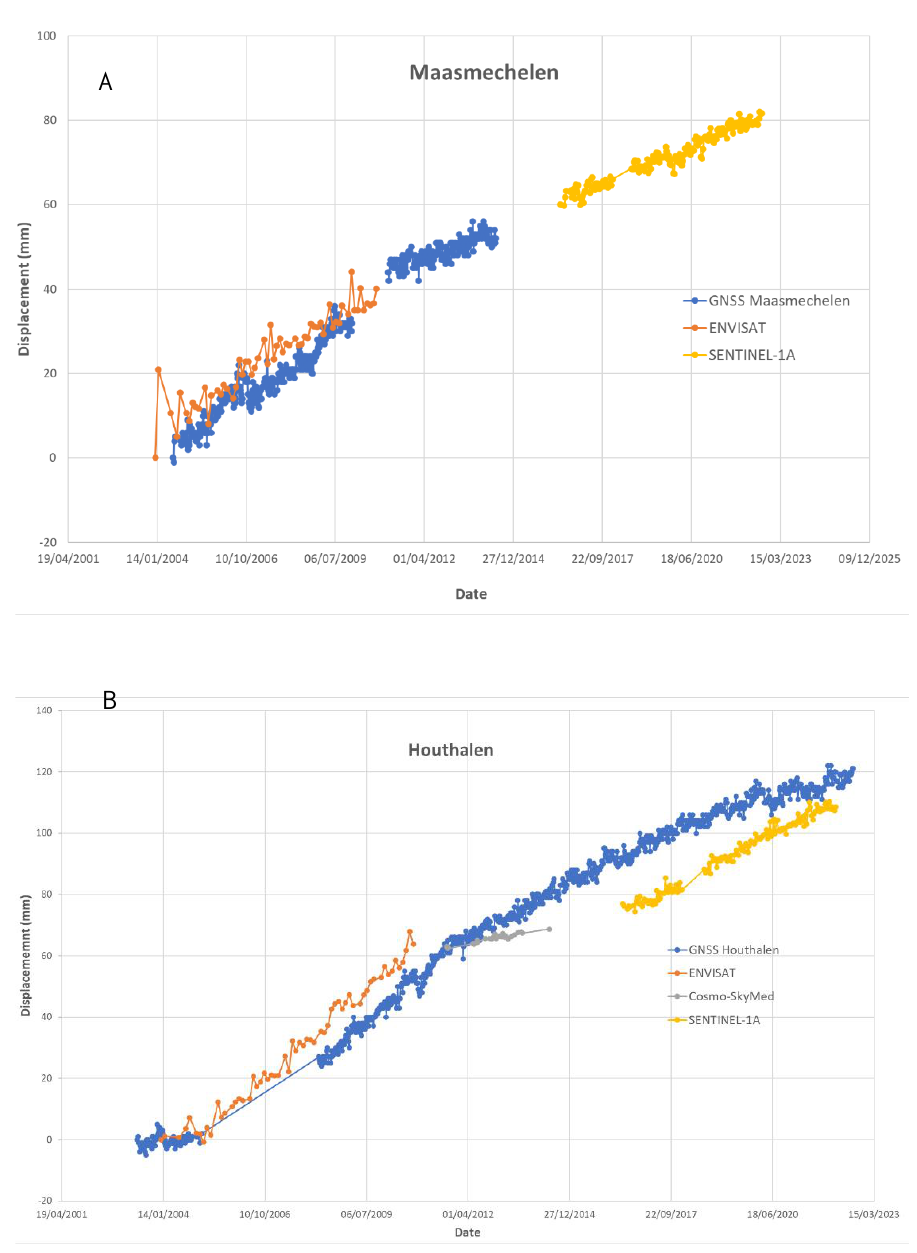
Figure 15. Time series of vertical displacement in LOS of the GNSS antennas vs. the displacement time series of the PS (in LOS) located in a 250 m buffer around the antennas. ( A ) Maasmechelen (MAME), ( B ) Houthalen (HOU).